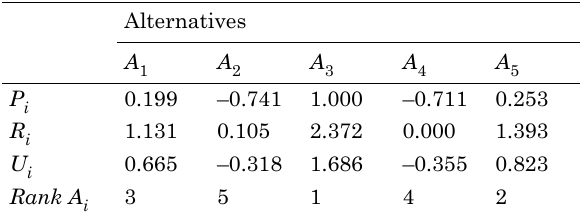
Table 5. normalised positive and negative distances, the values of the calculated multi-criteria utility function values and final ranking of the alternatives Alternatives